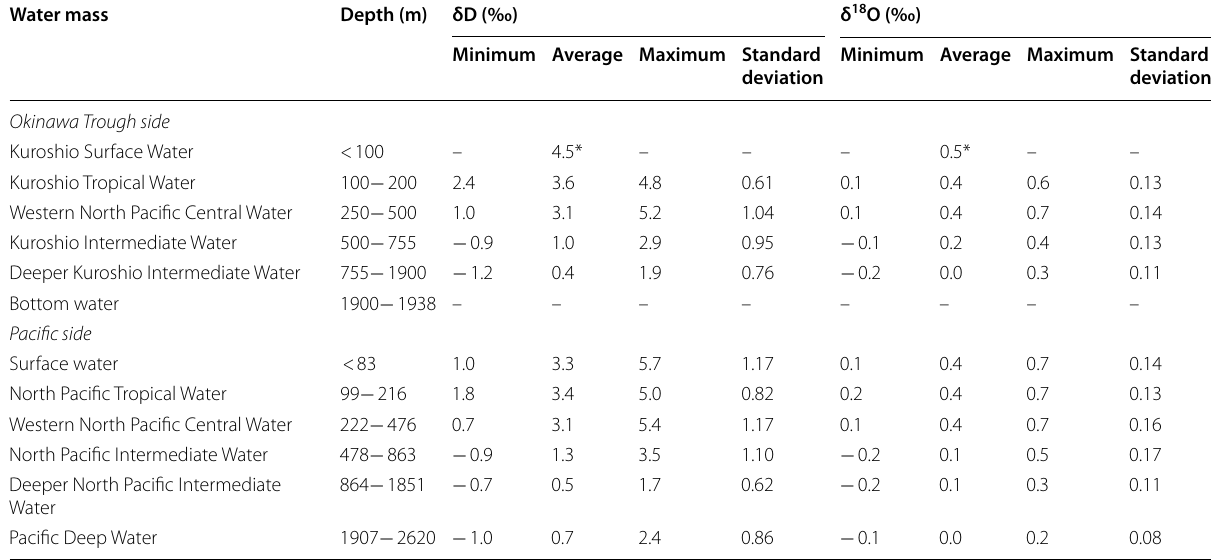
*Only one data available